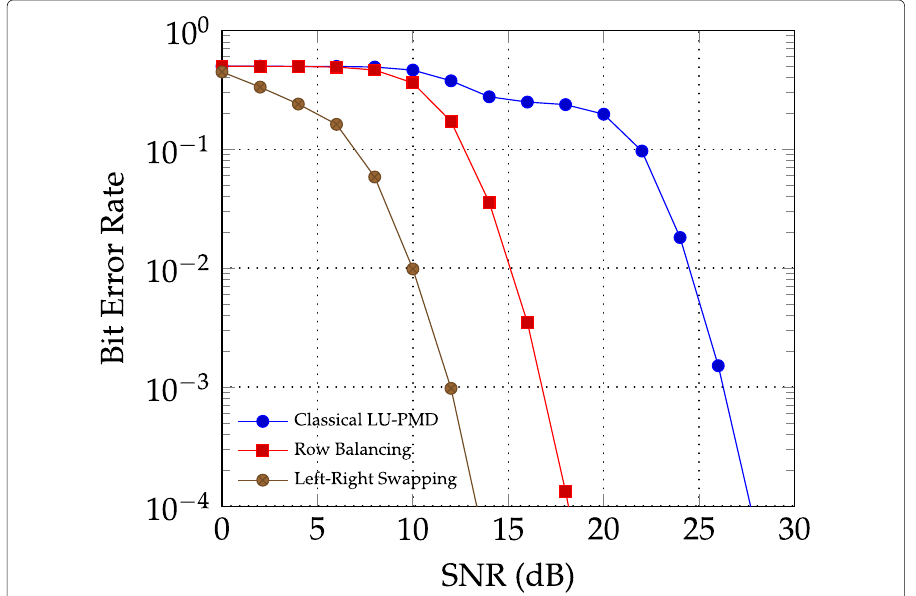
Significant improvement is obtained with the proposed method in both MIMO 3 × 3 contexts: indoor (5) and outdoor (6). Observe how the performance gain is very important in the more severe outdoor context. For example, the same BER level of 10 − 3 is reached with the proposed solution with about 5 dB drop in SNR compared to the “row balancing” trick. This is due to the fact that the post-filter matrix is better conditioned now, while the output filtering power remains reasonably high.